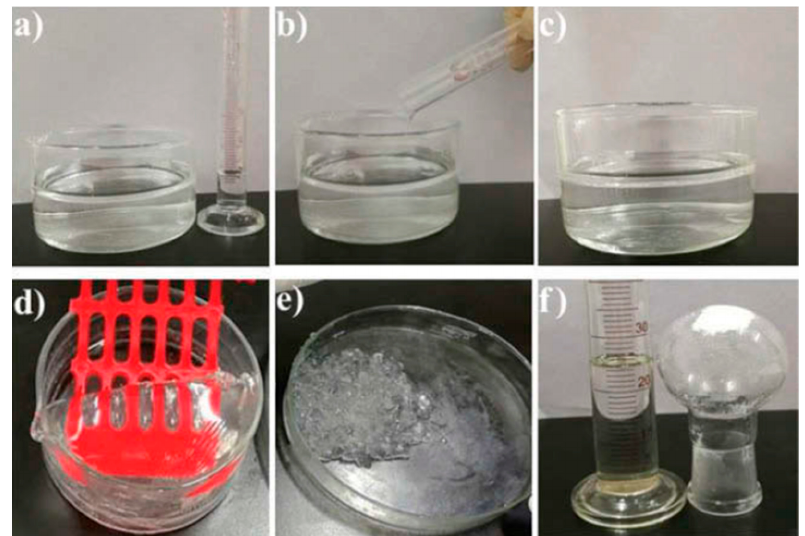
Figure 6. Removal of gasoline from oil/water mixtures using PSOG with a carrier solvent: ( a ) Bipha- sic system of gasoline and water; ( b ) PSOG in THF solution added to the gasoline layer; ( c ) Con- gealing the gasoline phase; ( d ) Removing the gel using a mesh device; ( e ) Removed gel; ( f ) Recov- ered gasoline and PSOG through distillation process [57].